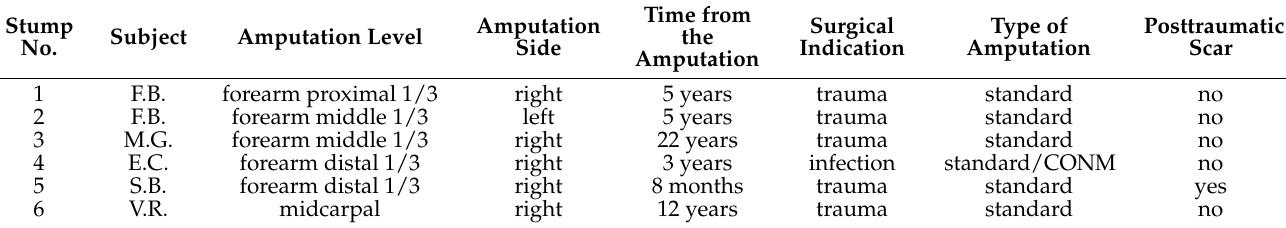
Table 1. The general characteristics of the amputation stumps. Stump